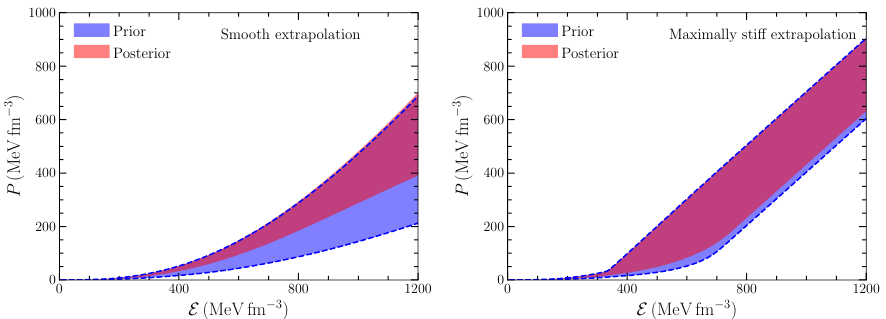
Figure 1. The 99.5% confidence intervals for the prior (blue) and posterior (light red) equations of state assuming a smooth high-density extrapolation ( left ) and a maximally-stiff high-density extrapolation ( right ).